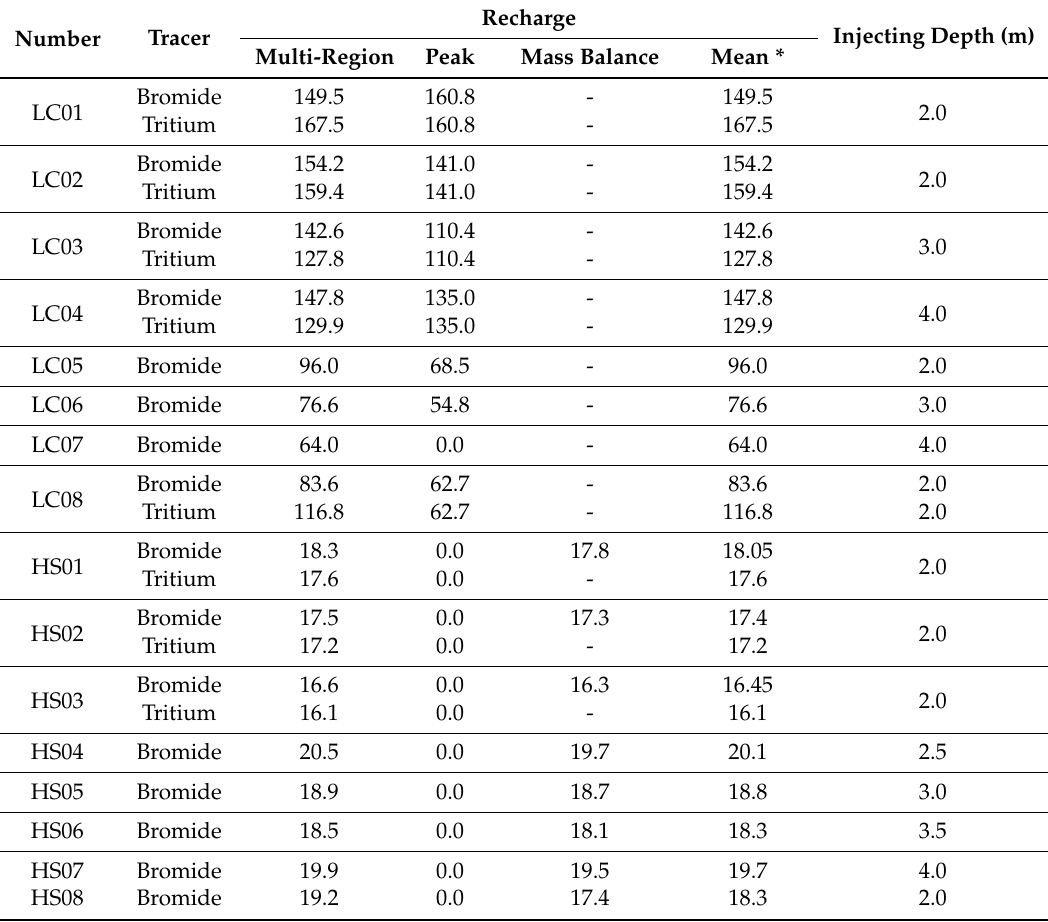
Table 3. Results of groundwater recharge by applied tracer methods,